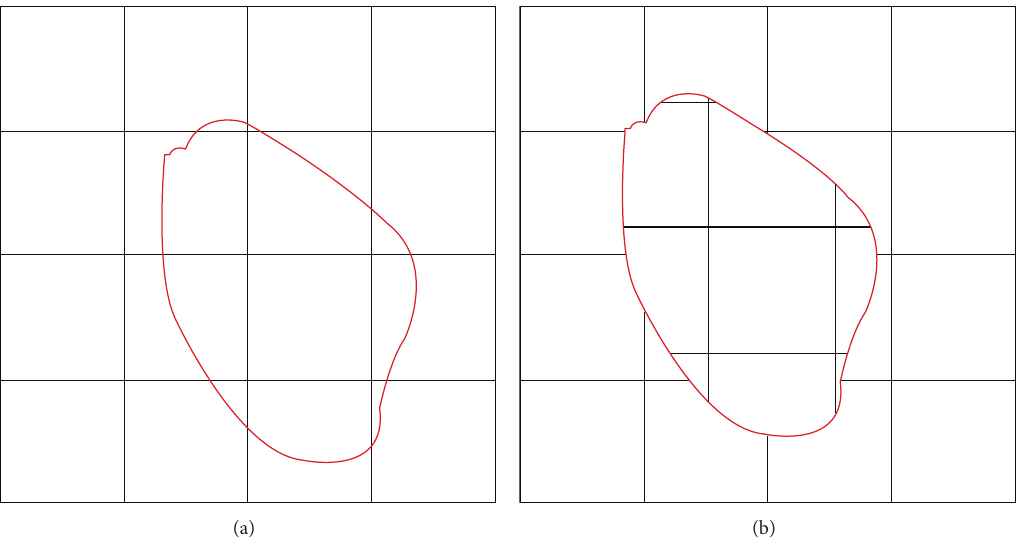
Figure 1: Illustration of BAG mismatch: the region within the red circle in upper left picture is copied and spliced into upper right picture. BAGs appearing within 8 × 8 block’s border are suspected to belong to regions from other pictures. This mismatch may appear also in copy-move forgery